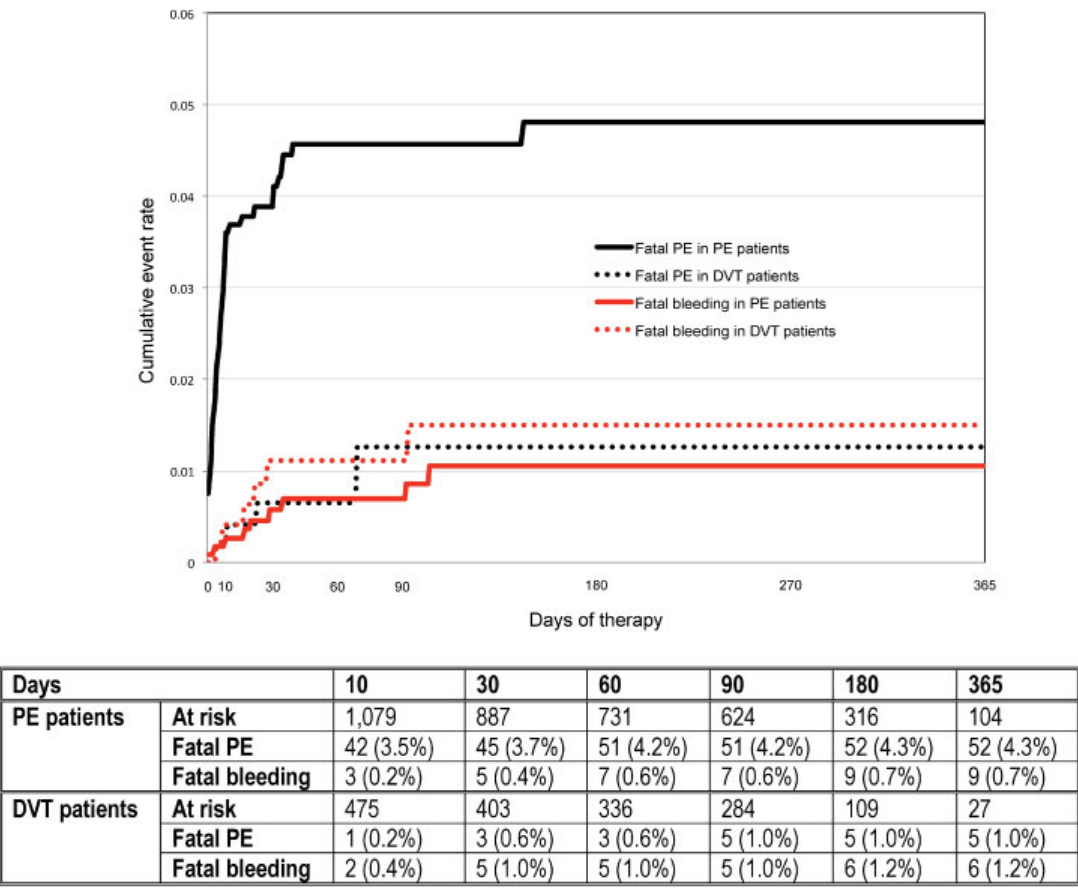
Fig. 2 Cumulative rates of fatal PE and fatal bleeding, according to initial VTE presentation. DVT, deep vein thrombosis; PE, pulmonary embolism.